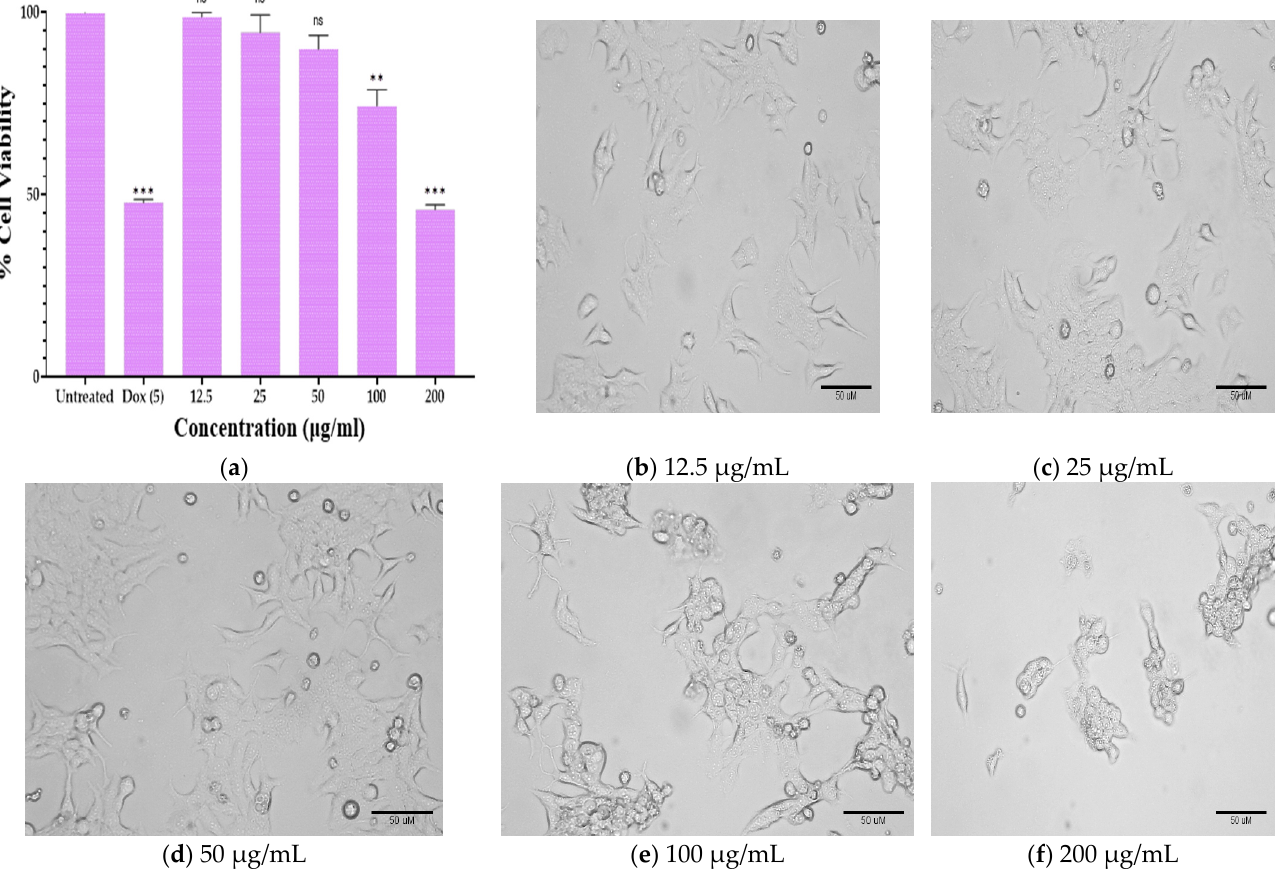
Figure 5. ( a ) Effect of PGLEO on cell viability and morphological characteristics; * p < 0.01 compared to control; ** p < 0.05 and *** p < 0.001 compared to control. ( b–f ) KB cells treated with PGLEO at various concentrations (12.5 to 200 µg/mL) for 24 h.